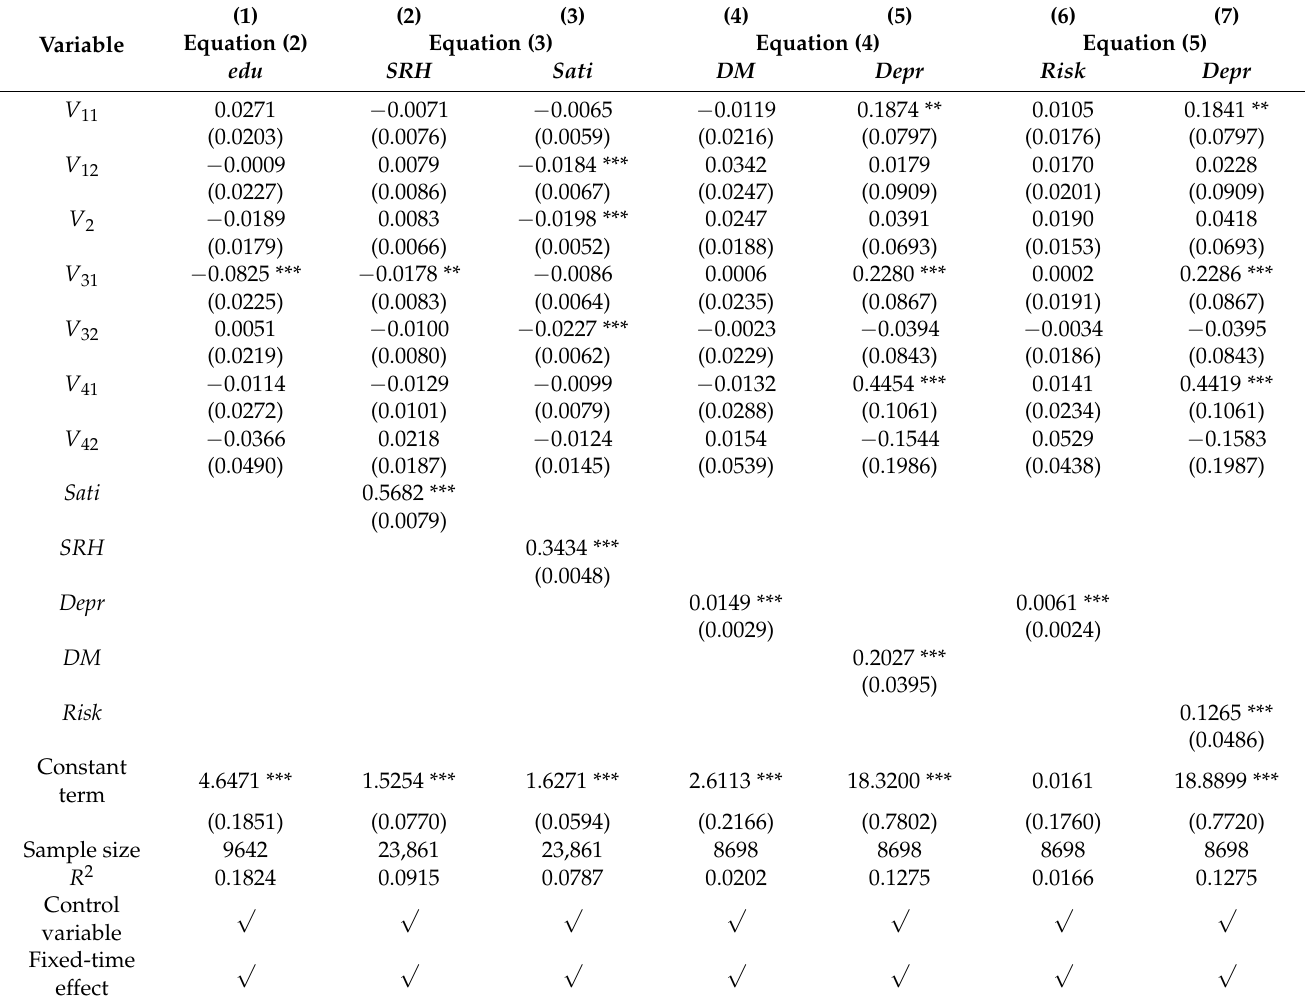
Table 8. Estimation results of the robustness